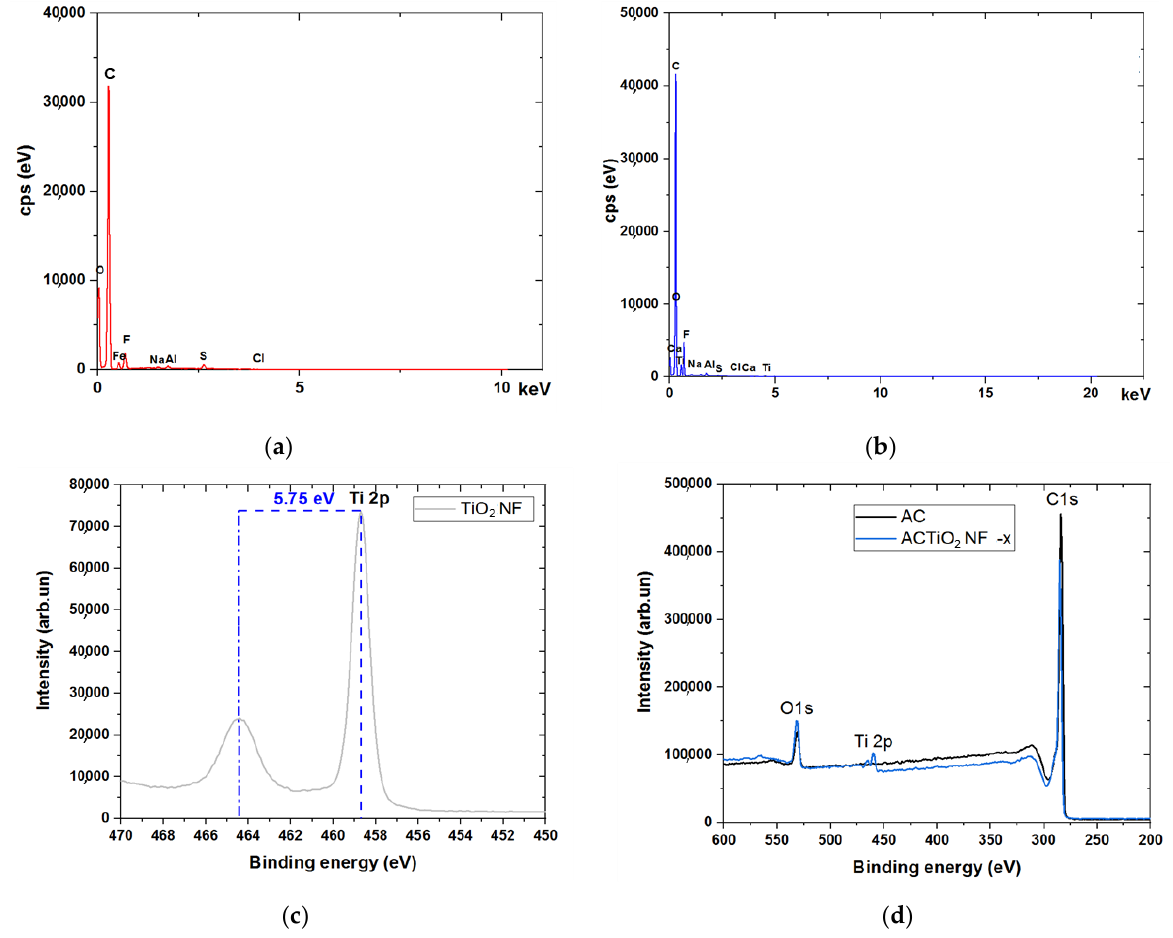
Figure 5. EDX spectra of ( a ) pristine AC ( b ) ACTiO 2 NF – x and XPS spectra of ( c ) Ti 2p for TiO 2 NF ( d ) the composite pristine AC and ACTiO 2 NF where x = 1.0 wt.% TiO 2 NF.